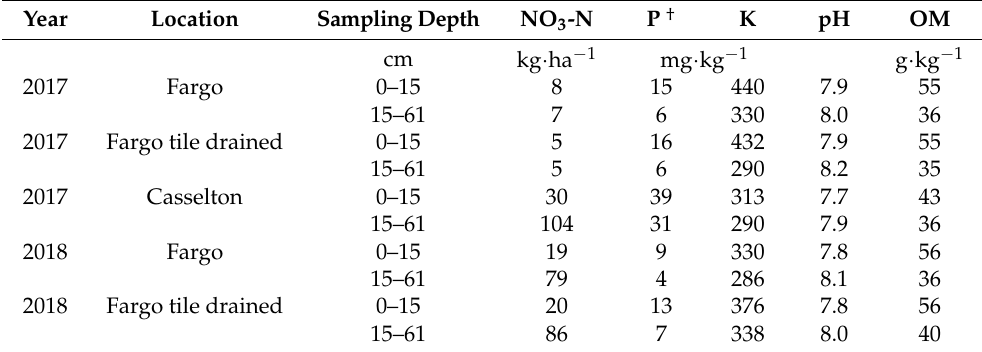
Table 2. Soil test results before seeding soybean at all environments in 2017 and 2018. Year Location Sampling